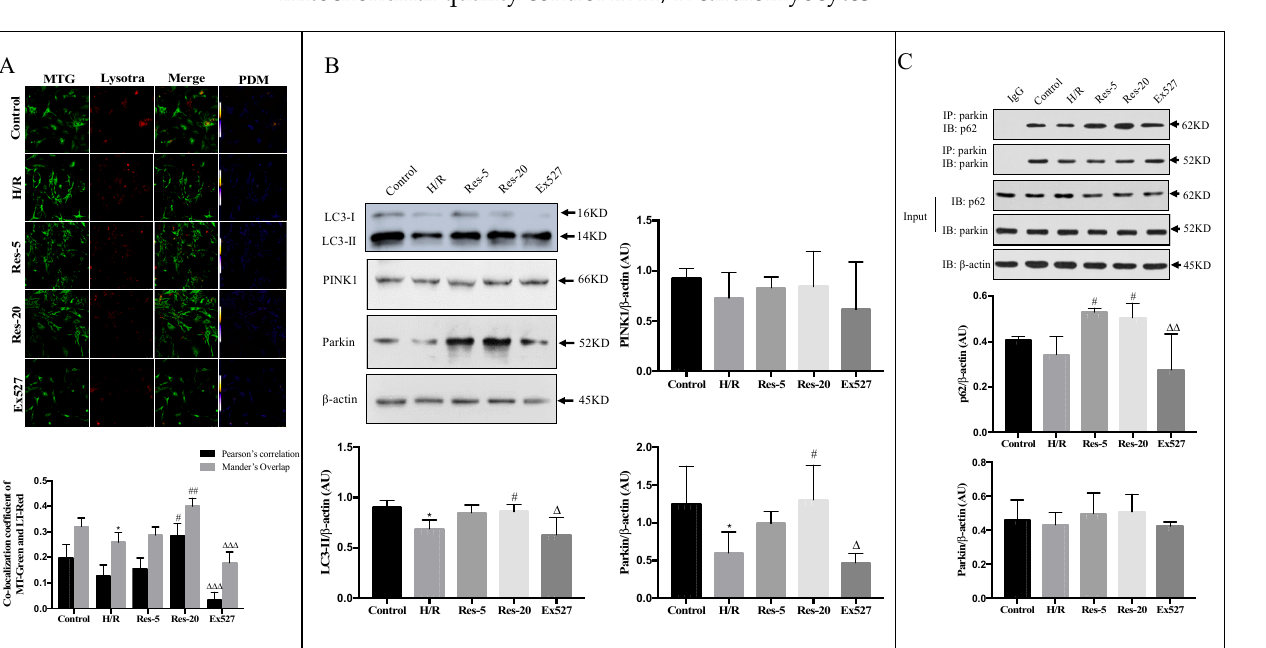
Figure 4. Resveratrol treatment improves the neonatal rat cardiomyocytes mitophagy induced by H/R, while this effect was abrogated by EX527. ( A ) Confocal fluorescent microscopic images of cardiomyocytes revealed the staining of mitochondrial autolysosomes. ( B ) Western blot was performed with cardiomyocytes lysate for expression of LC3, PINK1 and Parkin. ( C ) The interaction of Parkin with P62 was investigated by co-immunoprecipitation (Co-IP). Figures are representative images of three different samples. Results are expressed as mean ± S.D. * p < 0.05 vs. control group; # p < 0.05, ## p < 0.01 vs. H/R group; ∆ p < 0.05, ∆∆ p < 0.01, ∆∆∆ p < 0.001 vs. Res-20 group.